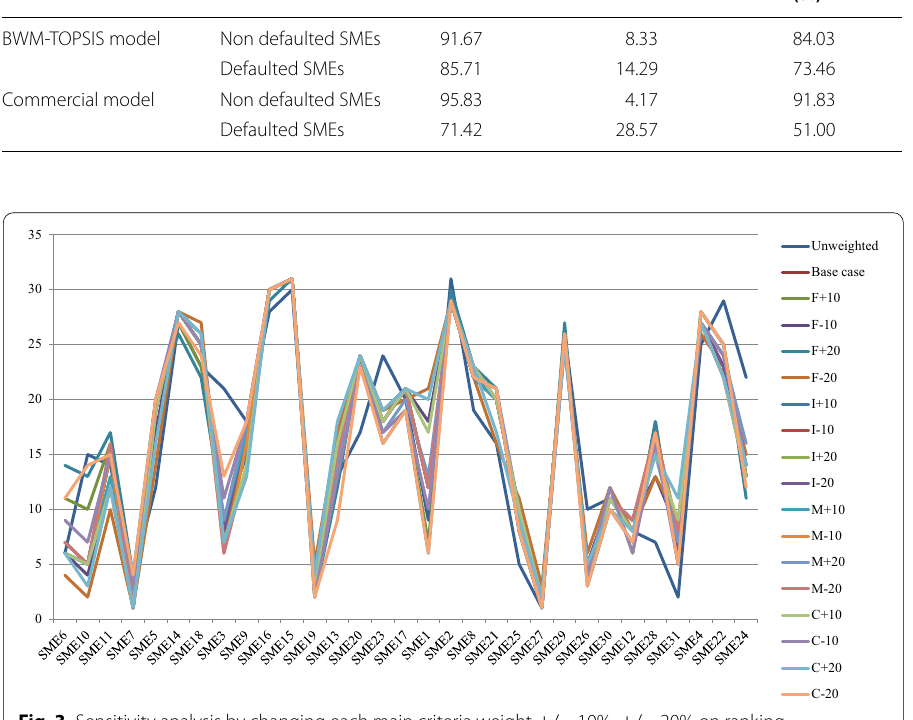
Fig. 3 Sensitivity analysis by changing each main criteria weight